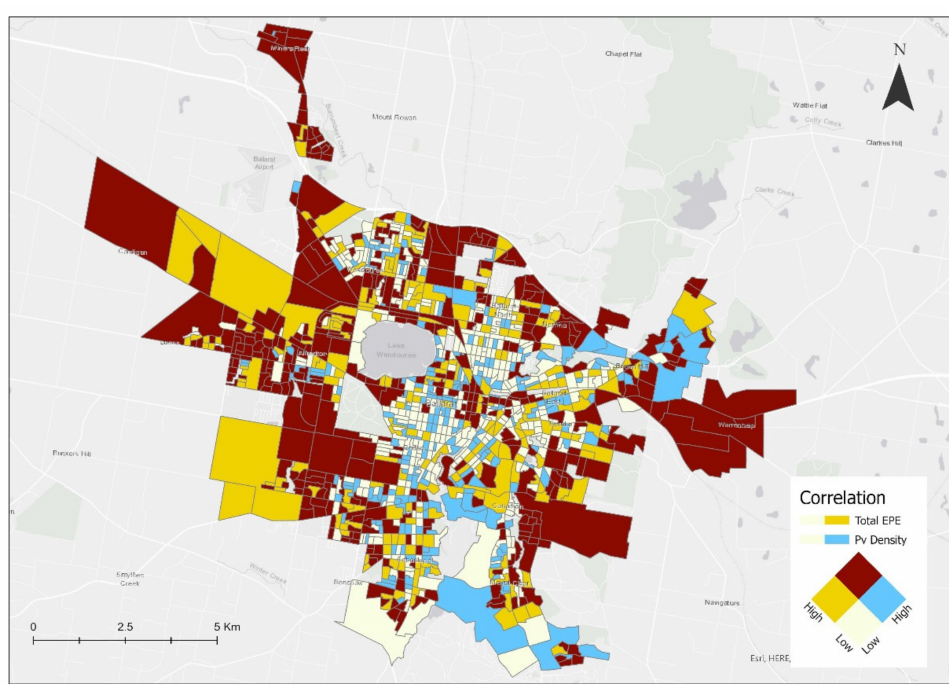
Figure 10. Correlation between EPE and PV-density